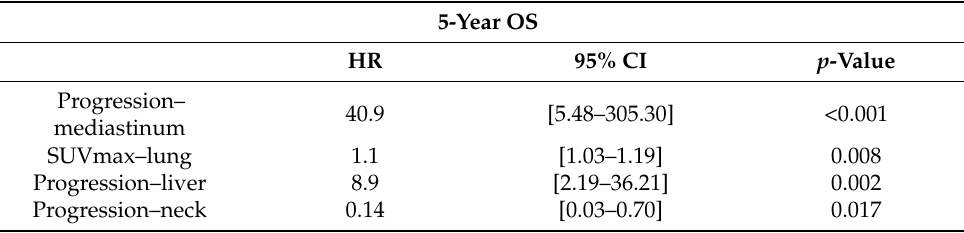
Table 9. Multivariate stepwise Cox analysis of 5-year OS. HR: hazard